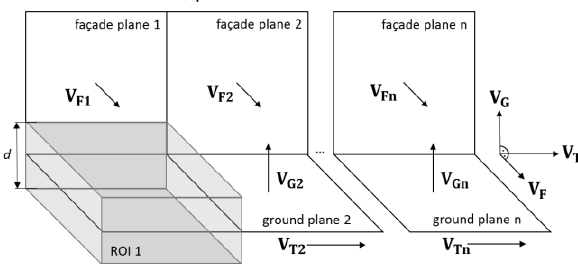
Figure 3. Ground vector calculation in stretches and ROI